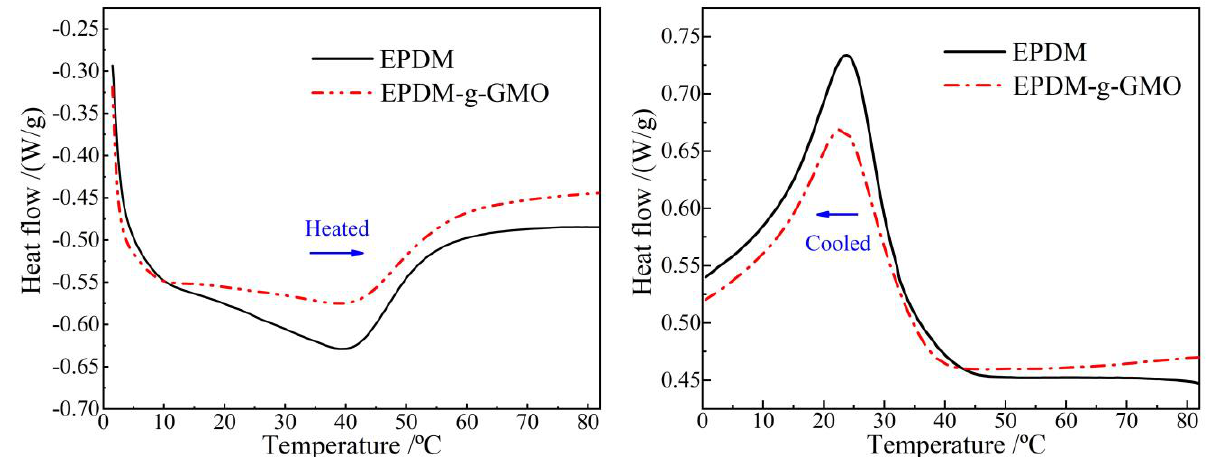
Figure 3. Infrared transmission spectra of EPDM and GMO/EPDM blend before and after crosslink- ing process.